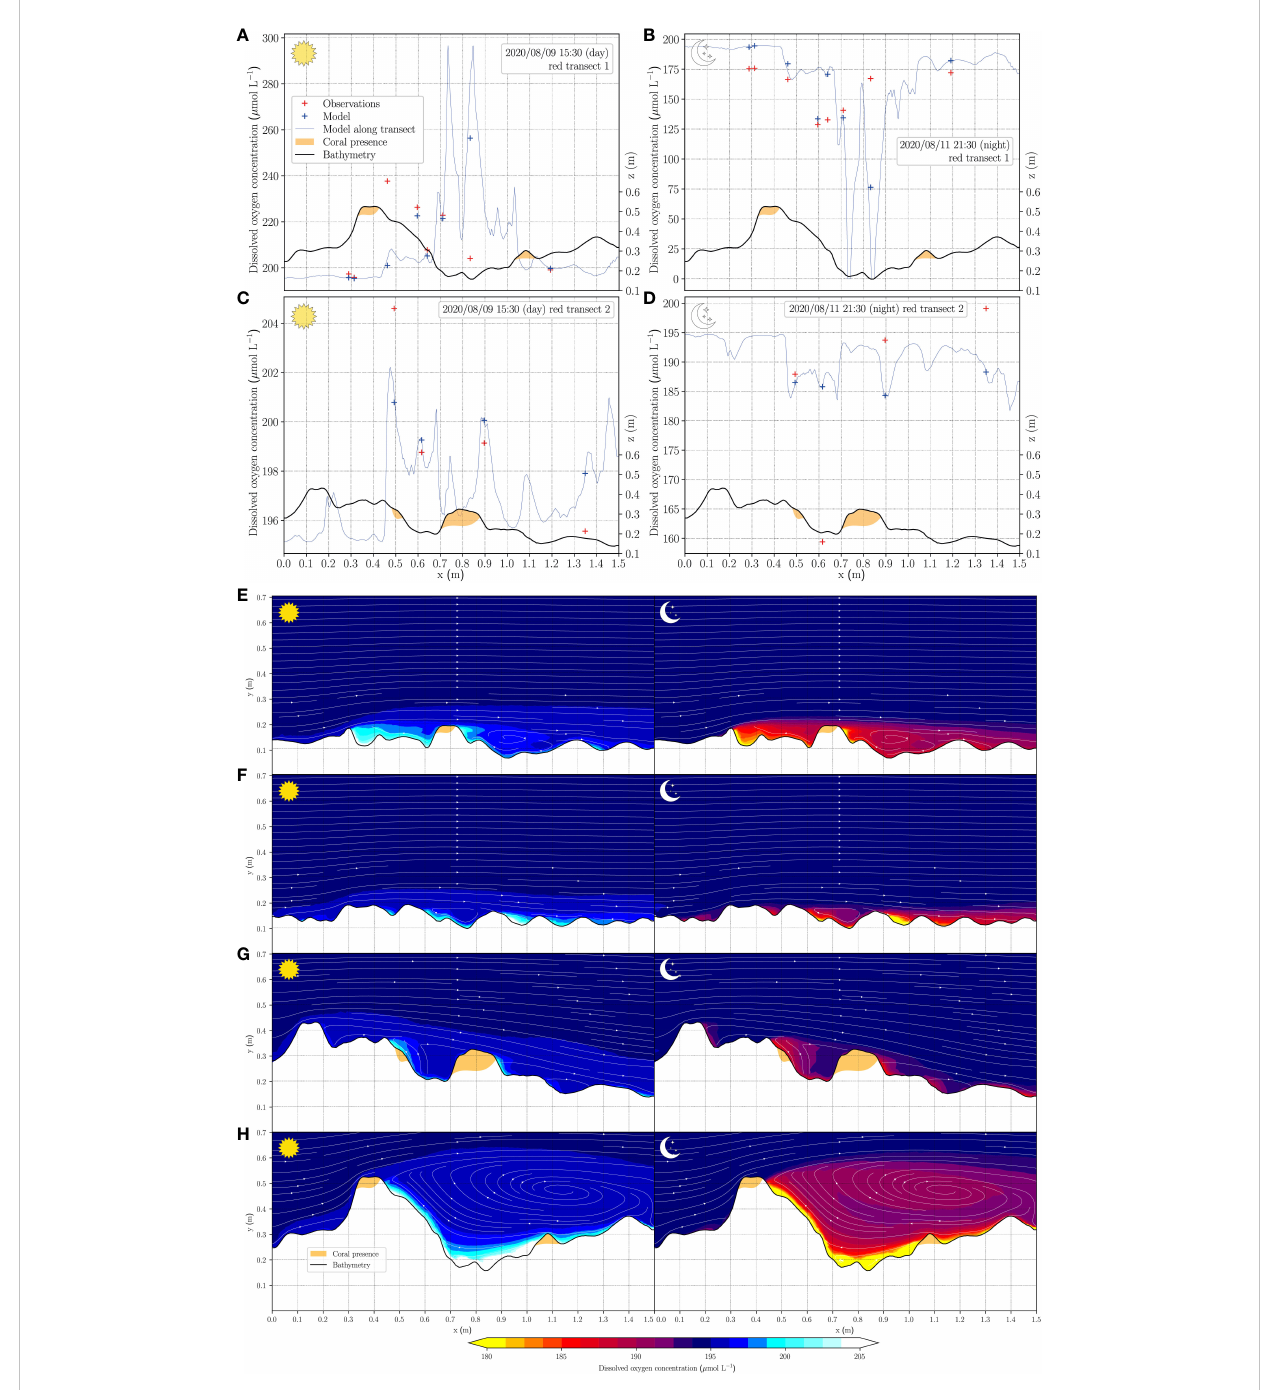
FIGURE 3 (top) Observed oxygen concentrations compared to simulated, at (A) transect line 1 during the day at 15:30 local time, (B) transect line 1 during the night at 21:30, (C) transect line 2 during the day at 15:30 local time, (D) transect line 2 during the night at 21:30, respectively, as shown in Figure 2. (bottom) Two-dimensional oxygen distribution patterns in the water column during day and nighttime. The left and right column represent day and night time, respectively. The white arrows indicate the velocity fi eld in the water column and the positions of corals are indicated in yellow in the seabed topography. A vertical slice of oxygen distribution patterns along transect line 4 is shown in (E) , with transect line in (F) and lines 2 and 1 in (G, H) ,